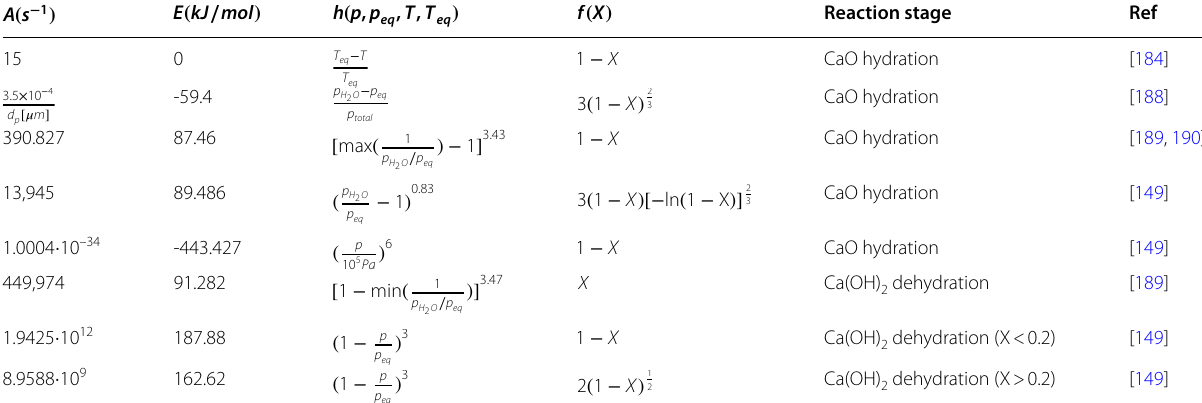
dehydration and CaO hydration 2